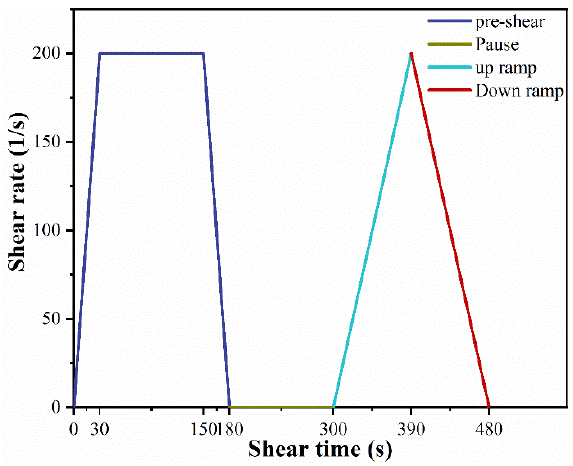
Figure 3. Variation of shear rate with